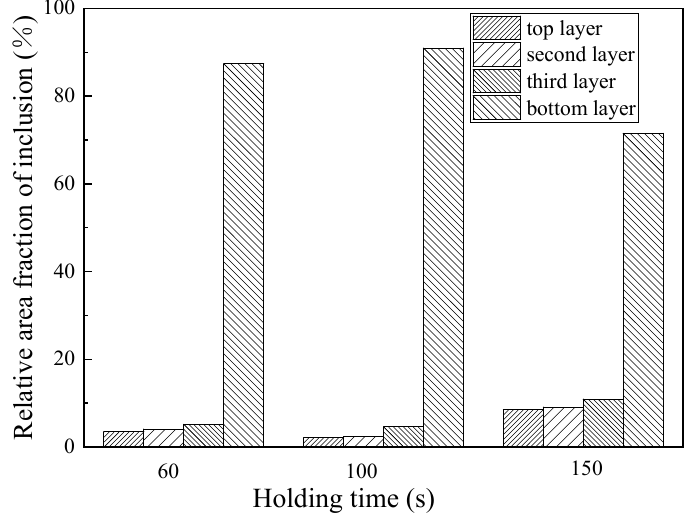
Figure 9. Variation of relative area fraction of inclusion with holding time.